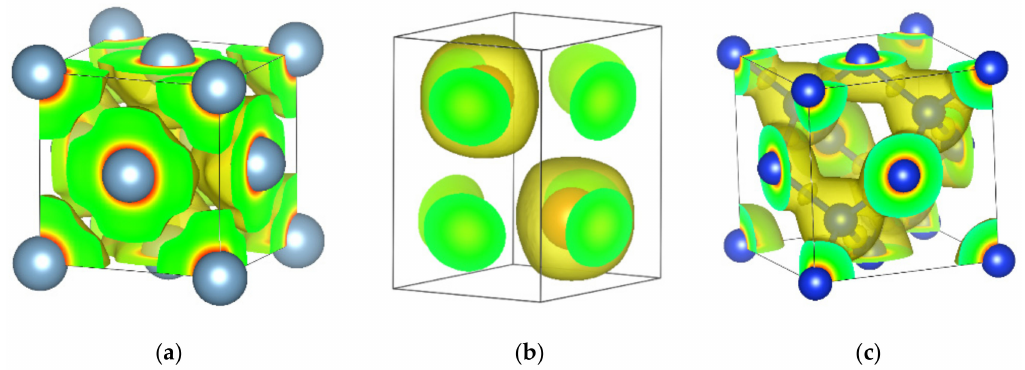
Figure 7. Kinetic energy densities within the unit cells of ( a ) fcc Al, ( b ) hcp Mg, and ( c ) cubic diamond Si